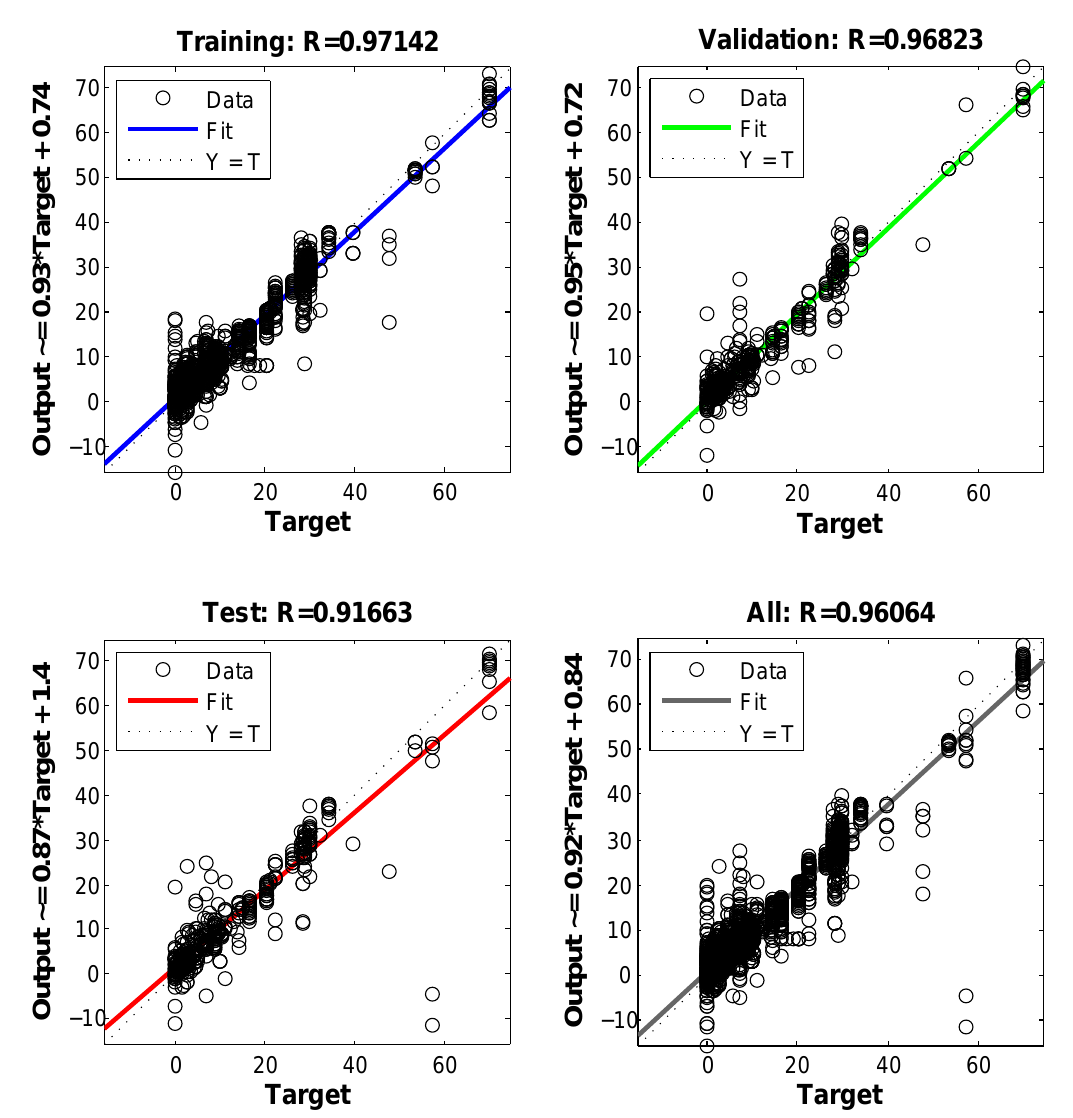
Figure 6. Comparison between the ANN predictions and the target values (experimental data) for Case 2: prediction of D col , D prim , out , NXP and D cas